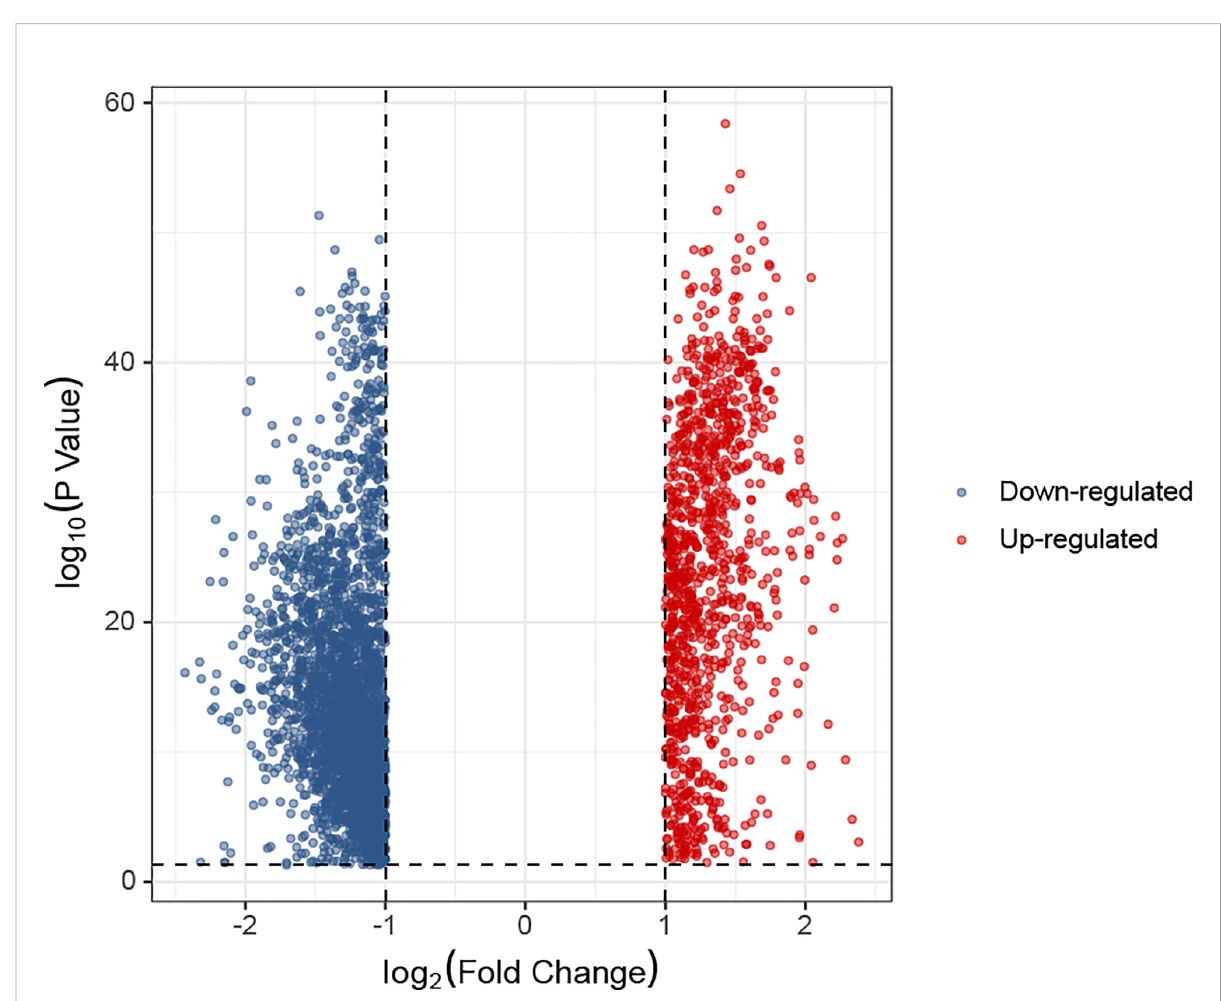
FIGURE 5 Difference in gene expression between K1 and K0 subgroups represented by a volcano